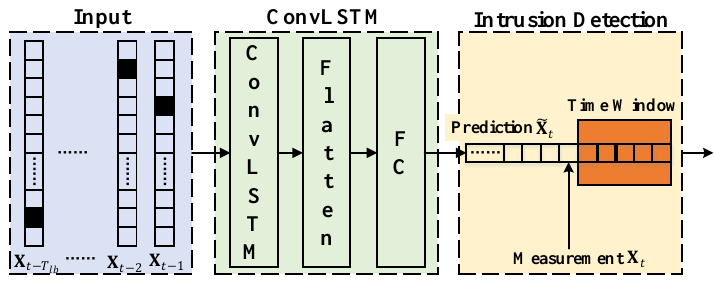
Figure 2. Diagram of ConvLSTM-based in-vehicle network intrusion detection